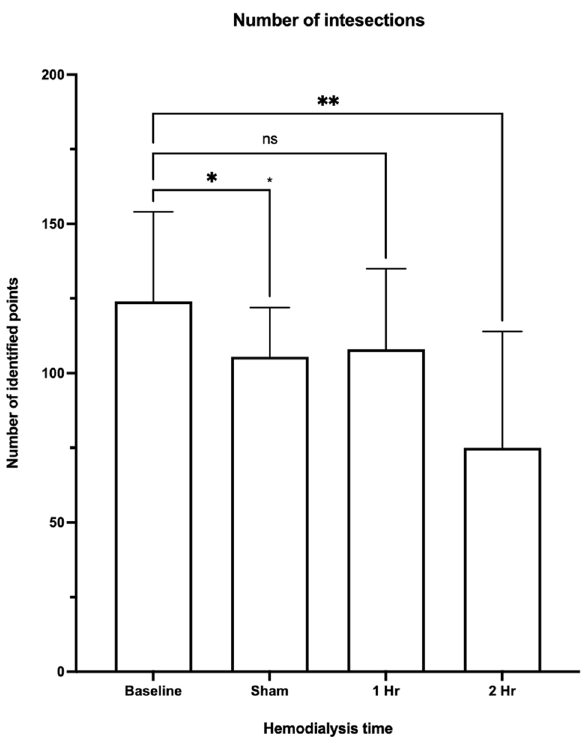
Figure 4. Tissue perfusion of the EDL microvasculature during HD as indicated by the number of grid intersections at different timepoints. Compared to baseline, the number of grid intersections was significantly reduced in the sham group and after a 2-h HD procedure (0.0192 and 0.0035 respectively; Ordinary one-way Anova with Dunnet correction for multiple comparisons) (image produced by B(GH) Janssen using; Prism 9